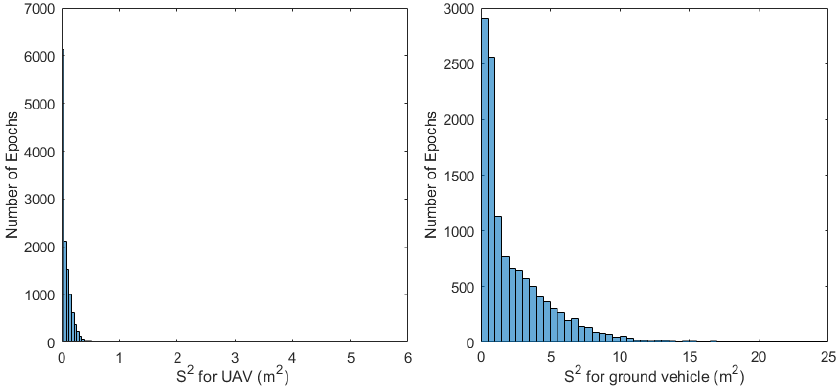
Figure 4. The distribution of S 2